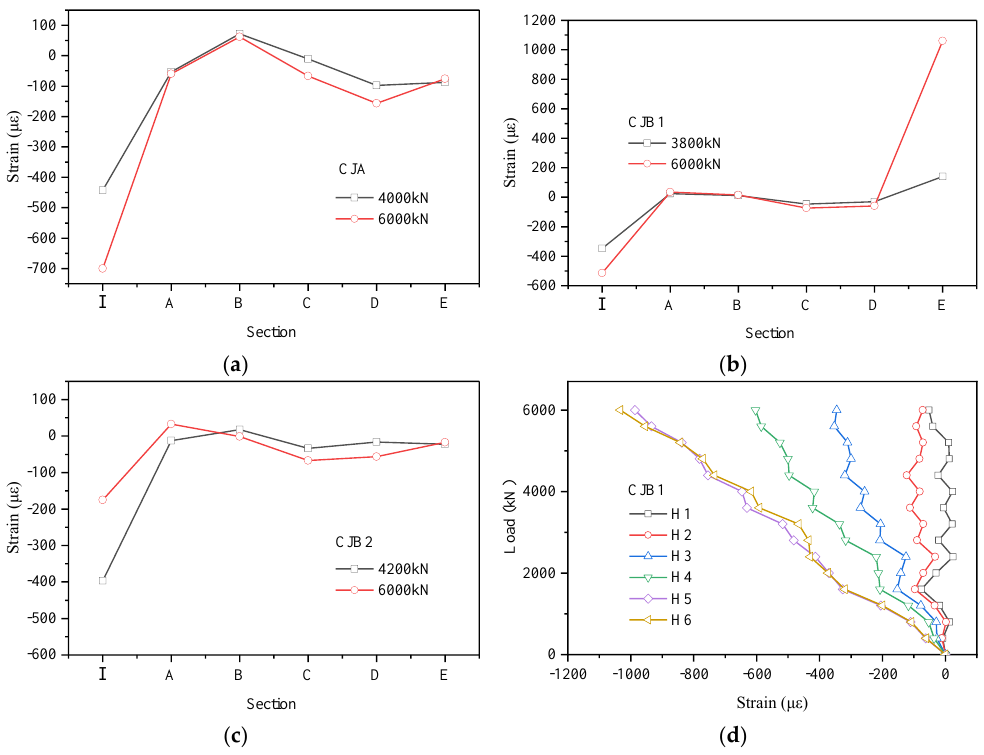
Figure 12. Load–strain curves of the concrete chord. ( a ) CJA; ( b ) CJB1; ( c ) CJB2; ( d ) the strain values of the first column strain gauge in CJB1.